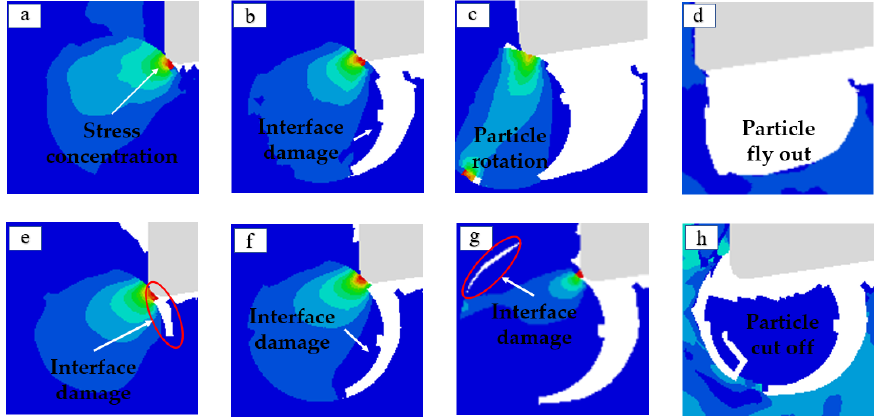
Figure 10. Simulation of TiC particle 4 failure removal process. ( a – d ) CCT. ( e – h ) UCT. Different colors represent the stress distribution, the brighter the color the more intense the stress concentra- tion.